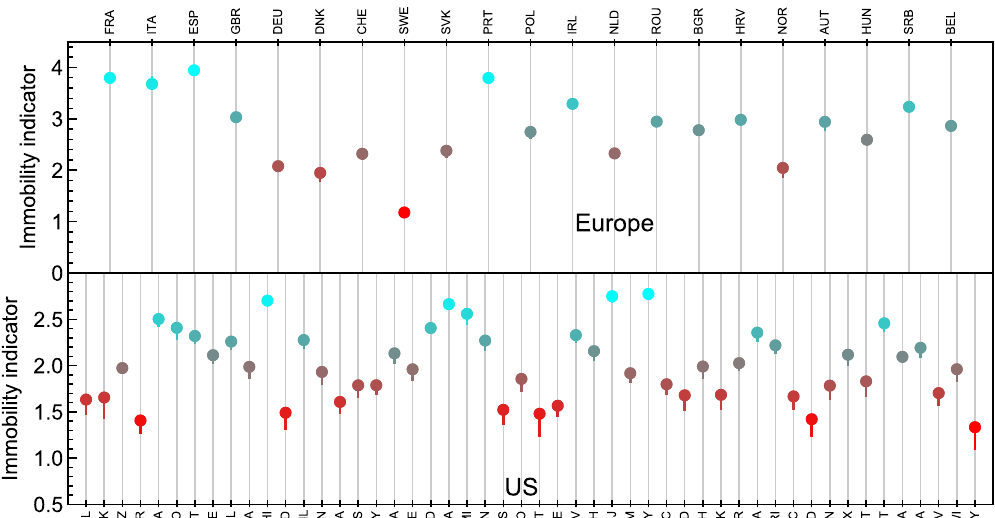
Figure 3. Immobility indicator for the European countries and the US states. Values of the immobility indicator (cid:31) M for Europe (top) and the US (bottom). The colour code corresponds to the ranking of each European country and each US state, matching the one used in Fig.